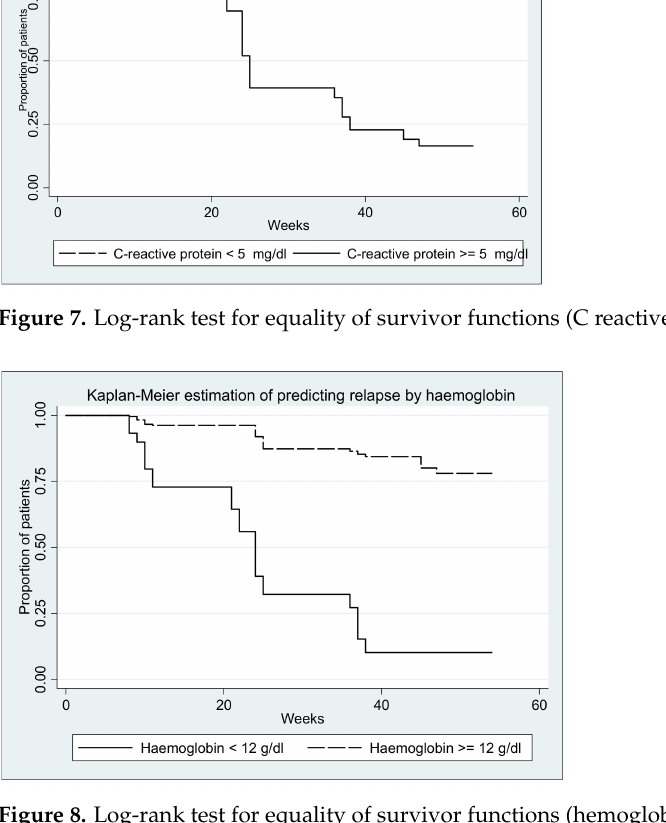
Figure 8. Log-rank test for equality of survivor functions (hemoglobin) p <